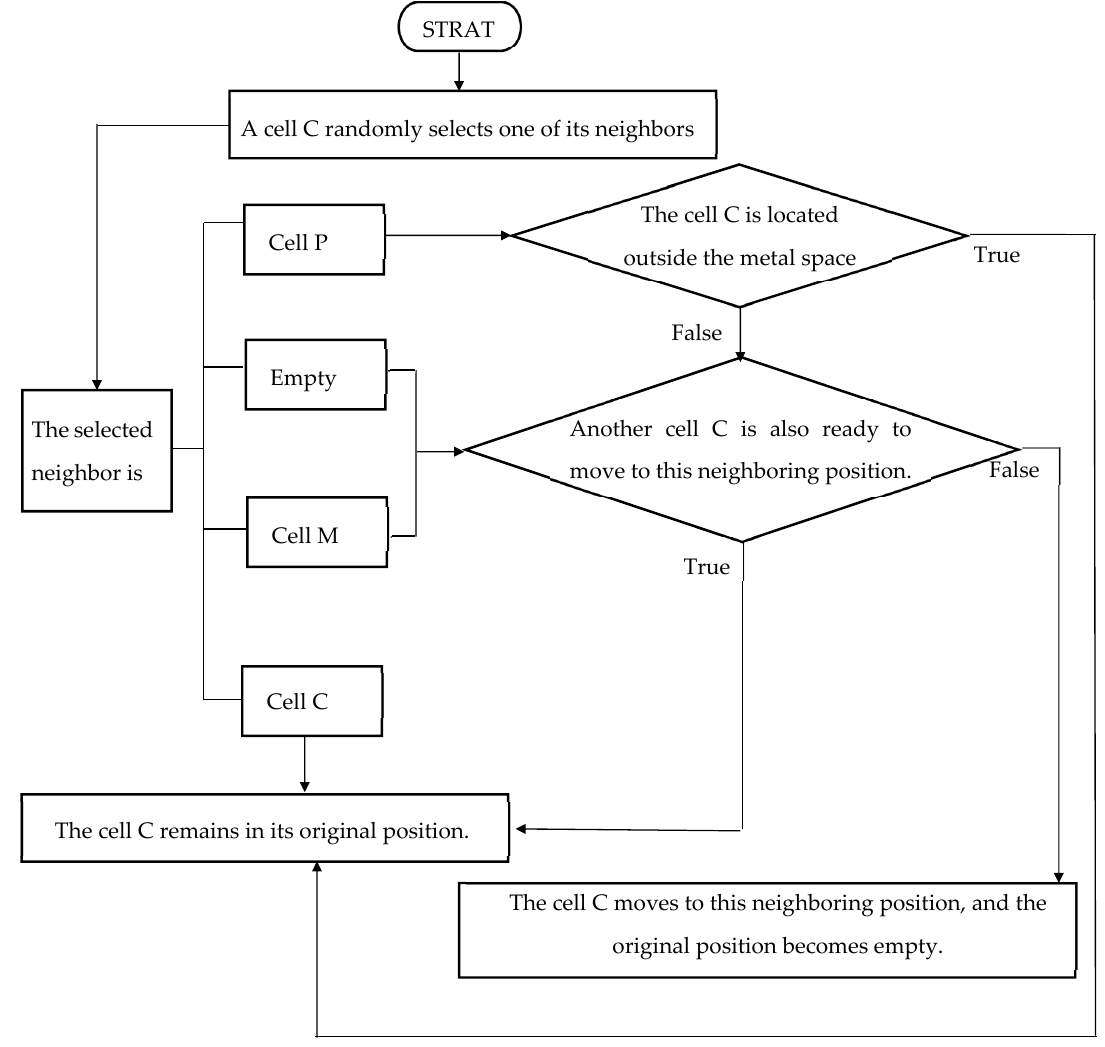
Figure 3. Cellular transformation rules.